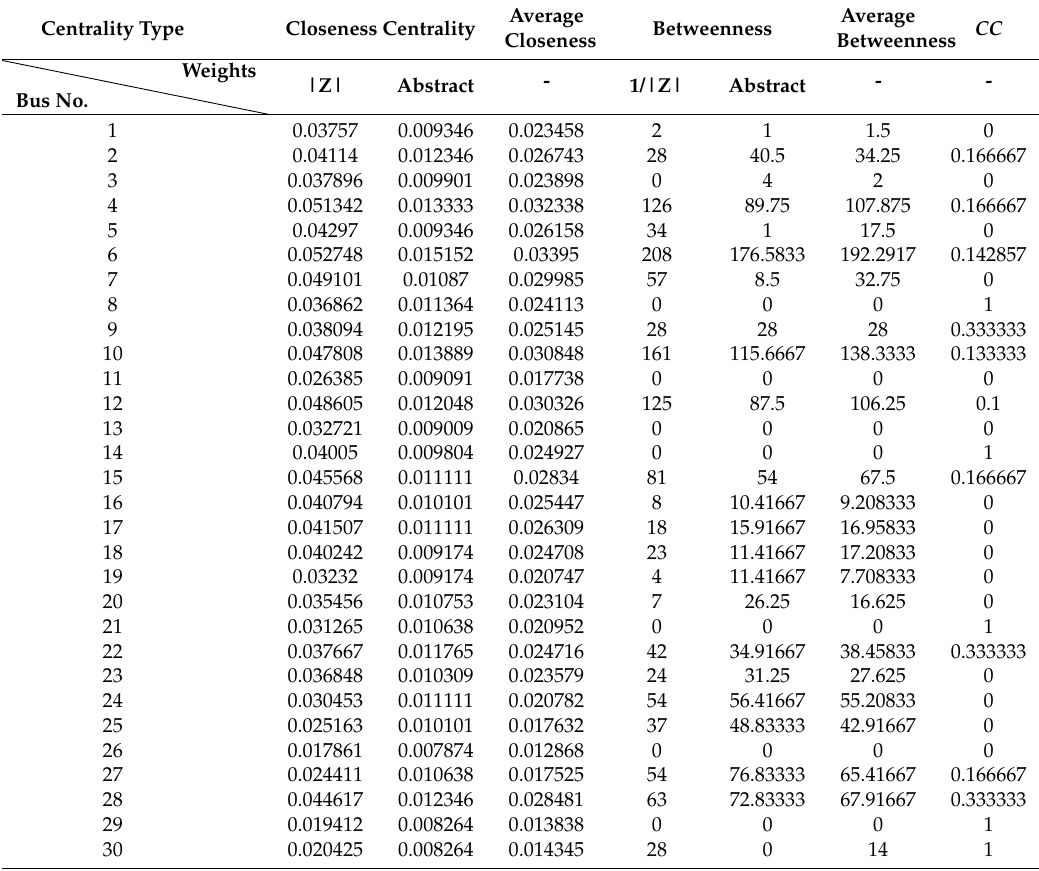
Average Average CC Betweenness Betweenness Closeness